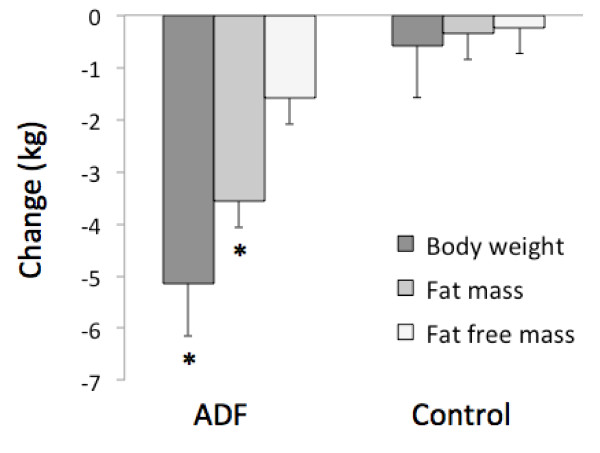
Body weight and body composition changes at week 12. Values reported as mean ± SEM. ADF: Alternate day fasting. *Body weight and fat mass significantly different (P < 0.001) from the control group at week 12 (Independent samples t-test). No difference between groups for fat free mass at week 12 (Independent samples t-test).